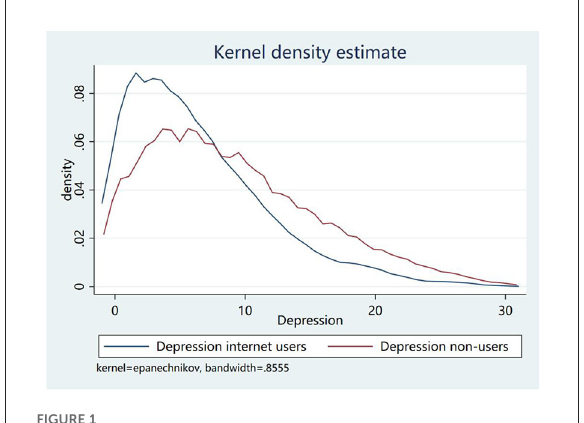
FIGURE1 Depression scores between internet users and non-users.